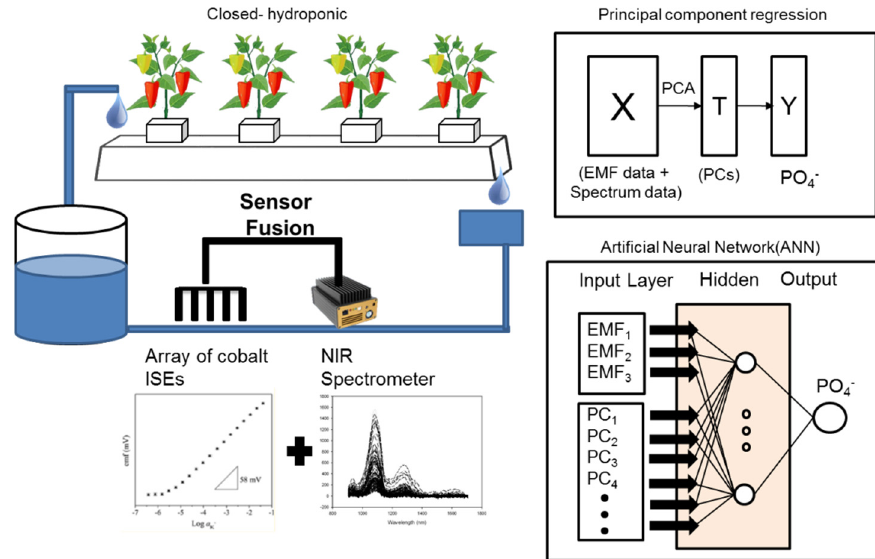
Figure 1. Concept art of newly developed calibration model combining near infrared (NIR) and cobalt electrodes using a multilayer neural network structure to detect phosphate concentrations in paprika hydroponic solutions.